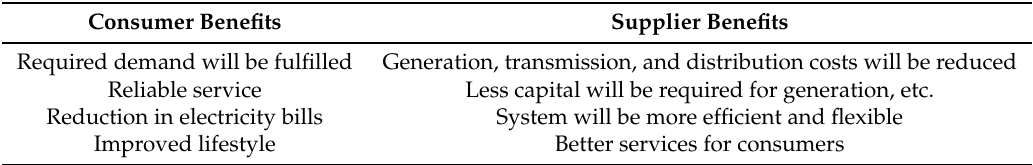
Table 5. Benefits of